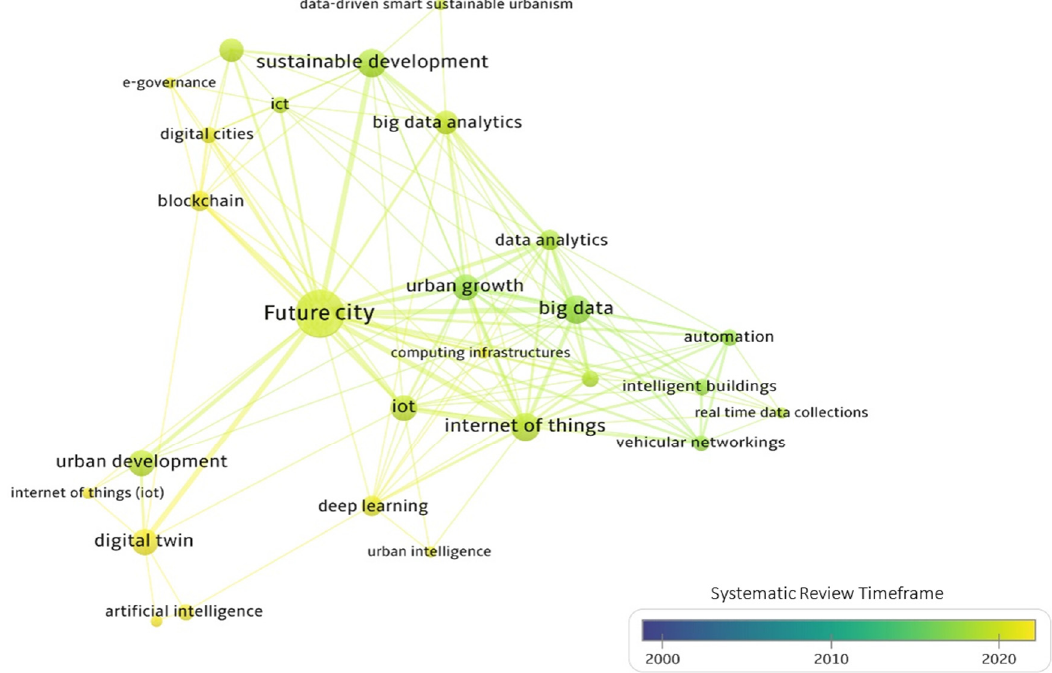
Figure 4. Scientometric analysis of literature. Source: Authors.